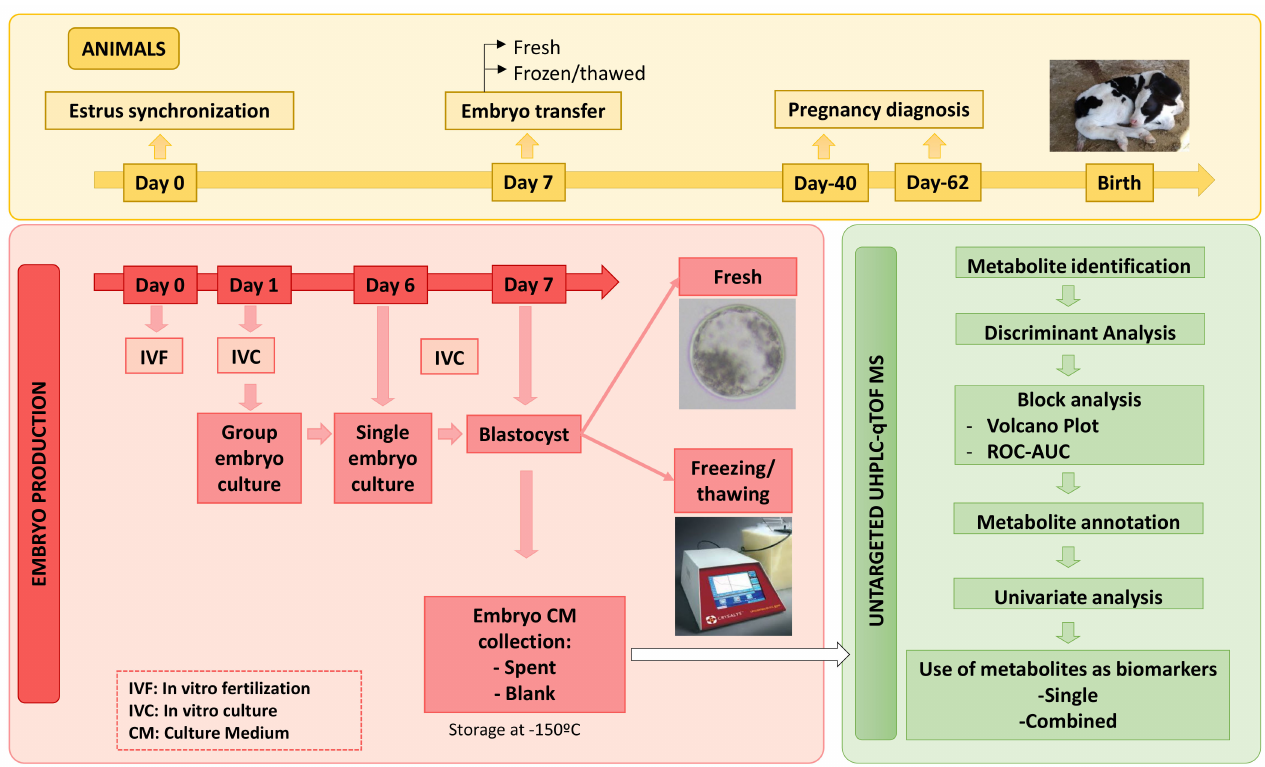
Figure 8. General experimental